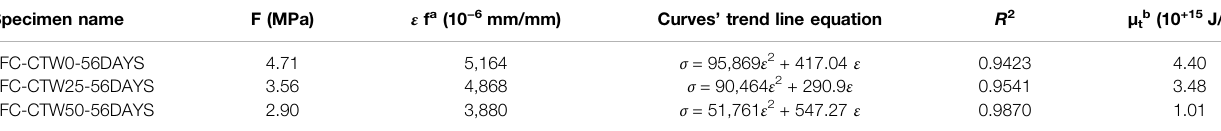
TABLE 9 | Compressive toughness of LFC-CTW0, LFC-CTW25 and LFC-CTW50 at age of 56